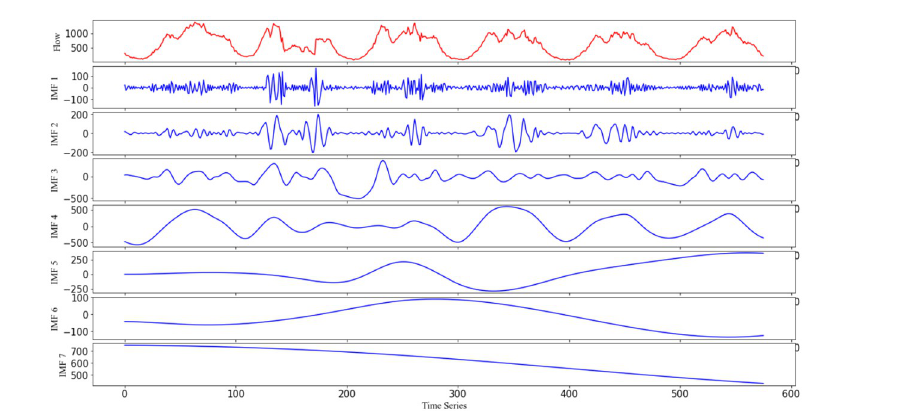
Fig 8. Decomposition results of the traffic flow after CEEMDAN.